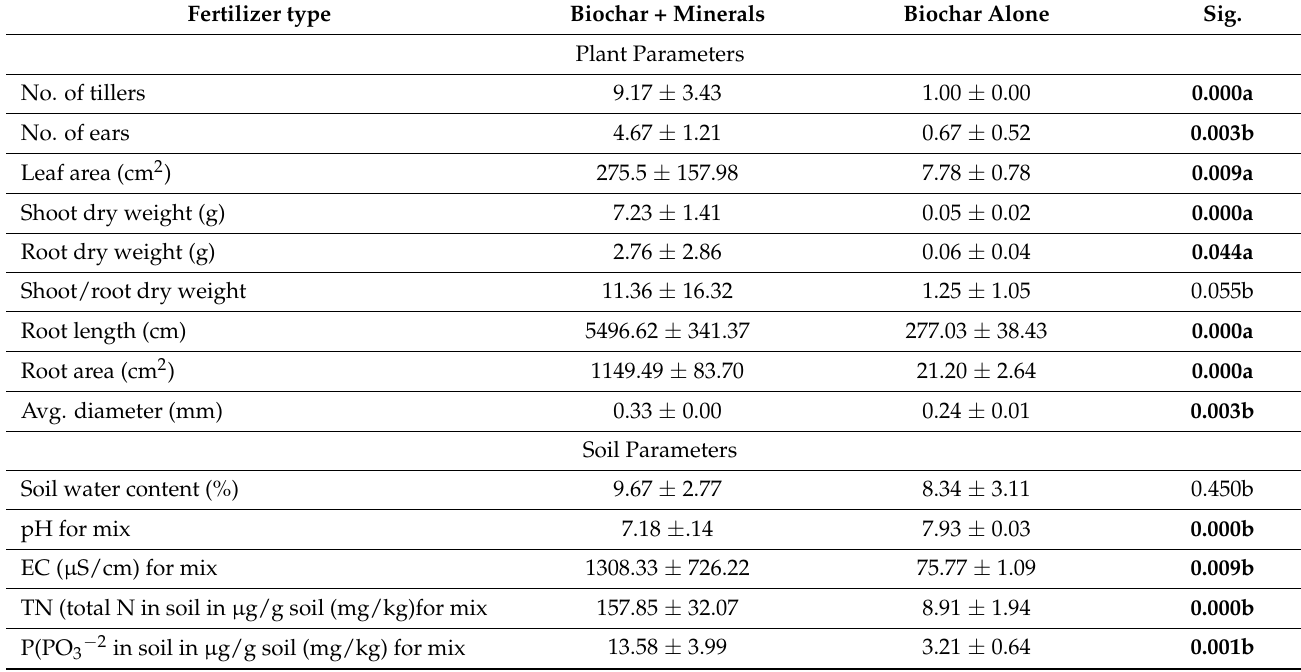
Table 2. Comparative effects of biochar alone and biochar with minerals on Rehan cultivar during the early growth stage (7 weeks). No. = number, Avg. = average, EC = electric conductivity ( µ S/cm), TN = total nitrogen (mg/kg), P = phosphorus (mg/kg), mix = mixed soil sample, sig. = significance of the test.